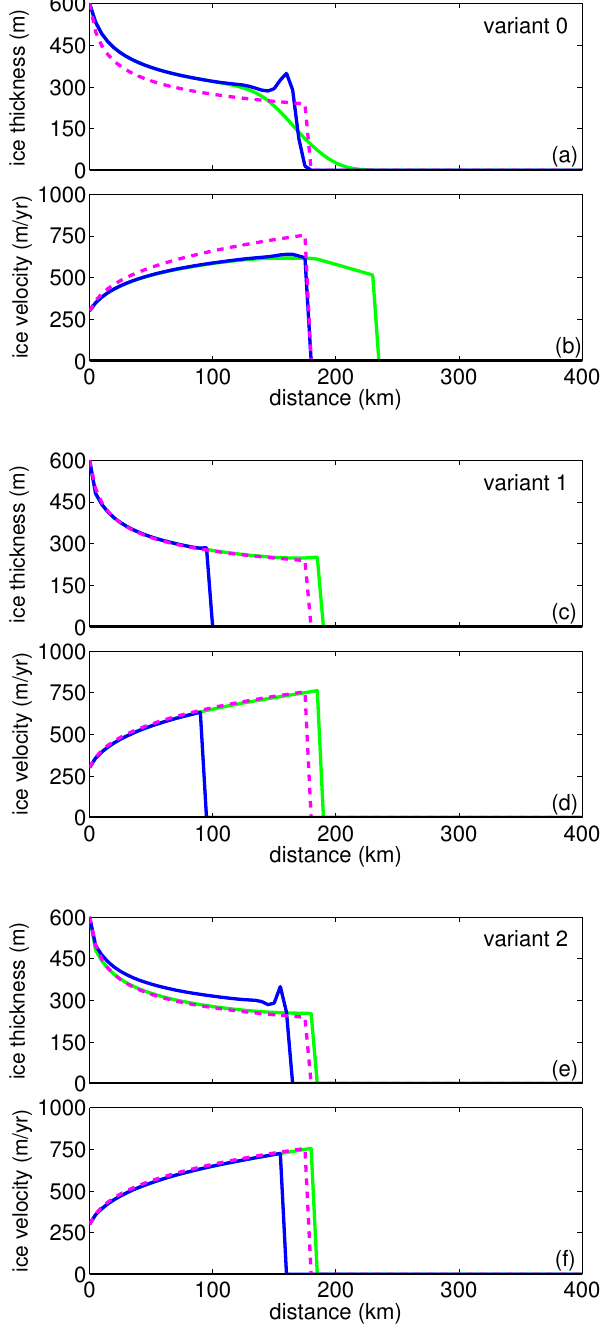
Fig. 6. Transient flow-line ice thickness and velocity profiles in lateral view after 300yr of time evolution, calculated using three different variants of residual mass treatment. The model result with adaptive time stepping is shown in blue, i.e., 1t ≈ 6–10yr. The re- sult with fixed short time step 1t = 1yr is plotted in green. Magenta dashed is the analytical profile after evolution time t = 300yr. A res- olution of 101 × 5km is used. CFBC and subgrid parameterization are not applied for the control case variant